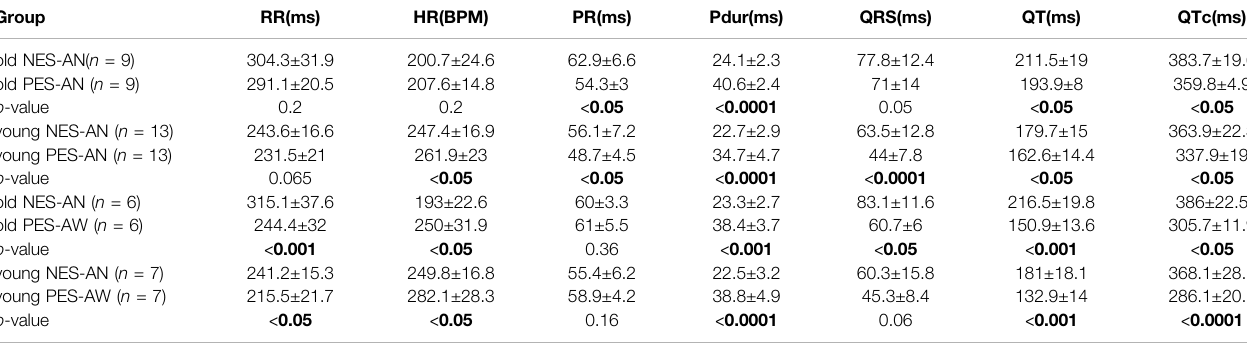
Values are means ± SD in ms or bpm. p value is calculated by homoscedastic Student ’ s t-test. p values that are statistically signi fi cant